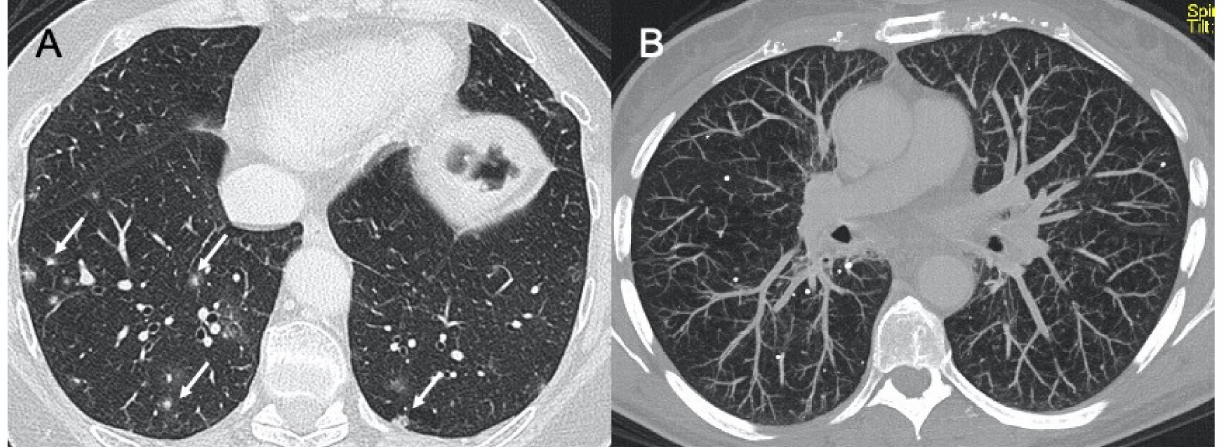
Figure 7. Varicella. A case of acute varicella pneumonia ( A ) with focal nodular consolidations (arrows) and its chronic form with small, tiny calcifications, well-visible in Maximum Intensity Projection (MIP) reconstruction ( B